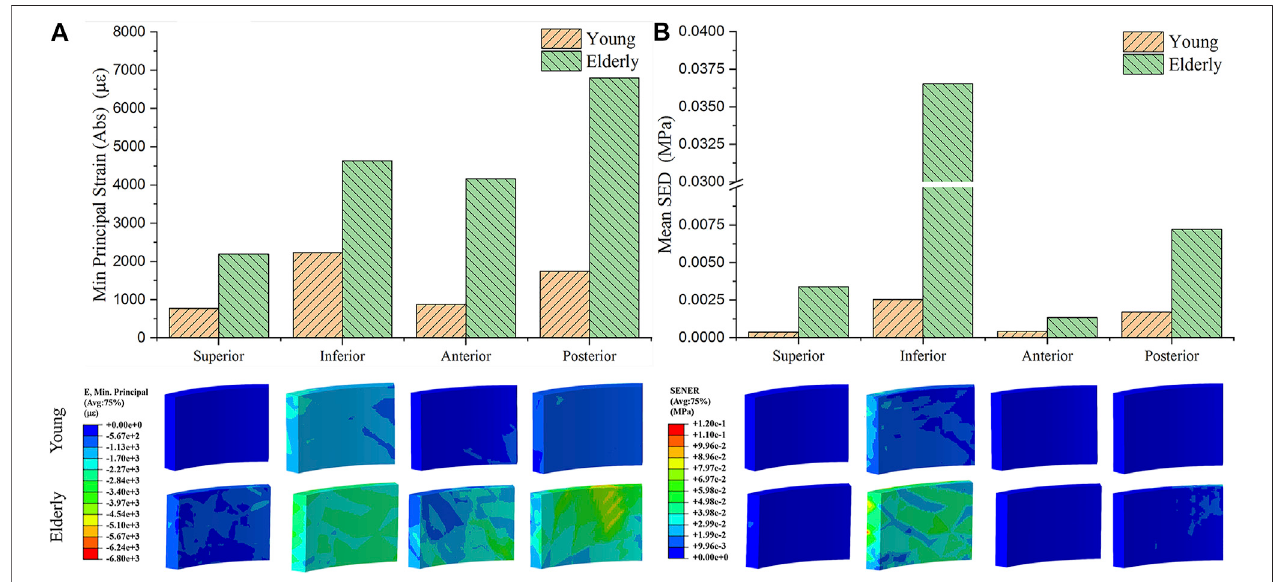
FIGURE 2 | The minimum principal strain (A) and SED (B) of cortical bone in four quadrants of the mid femoral neck between the young and the elderly models.